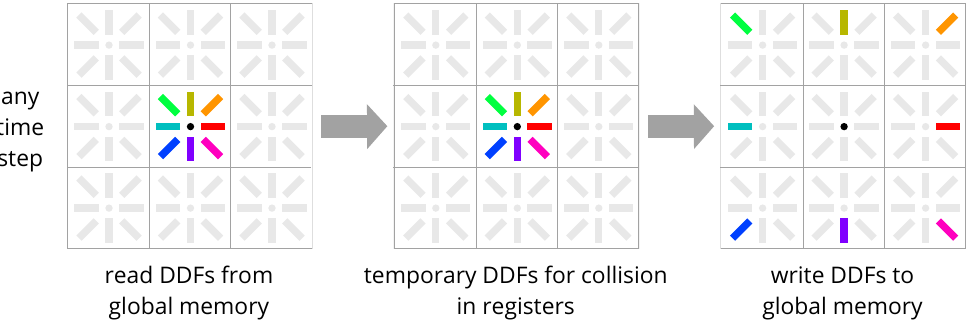
Figure 2. One-Step-Pushstreamingscheme.